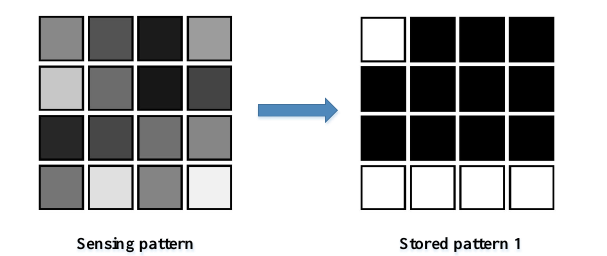
Figure 8. The detected pattern on the second layer and the similarity measure with the first stored pattern. The similarity measurement is based on network synchronization time and